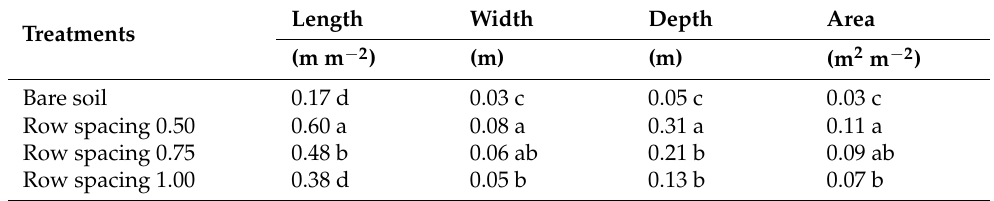
Table 2. Cracking properties in the bare soil and maize-cultivated soil under different row spacings. Length Width Depth Area Treatments (m m − 2 ) (m) (m) (m 2 m − 2 ) Bare soil 0.17 d 0.03 c 0.05 c 0.03 c Row spacing 0.50 0.60 a 0.08 a 0.31 a 0.11 a Row spacing 0.75 0.48 b 0.06 ab 0.21 b 0.09 ab